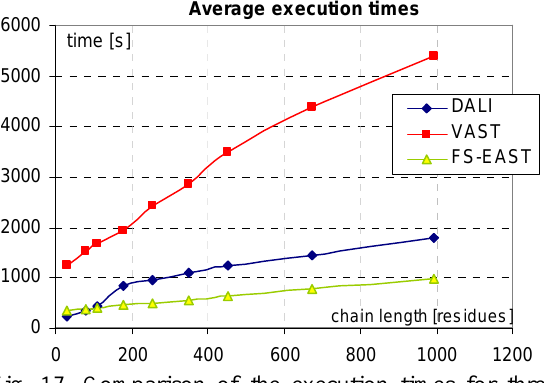
Fig. 17. Comparison of the execution times for three similarity searching algorithms: DALI with preselec- tion, VAST and FS-EAST without any